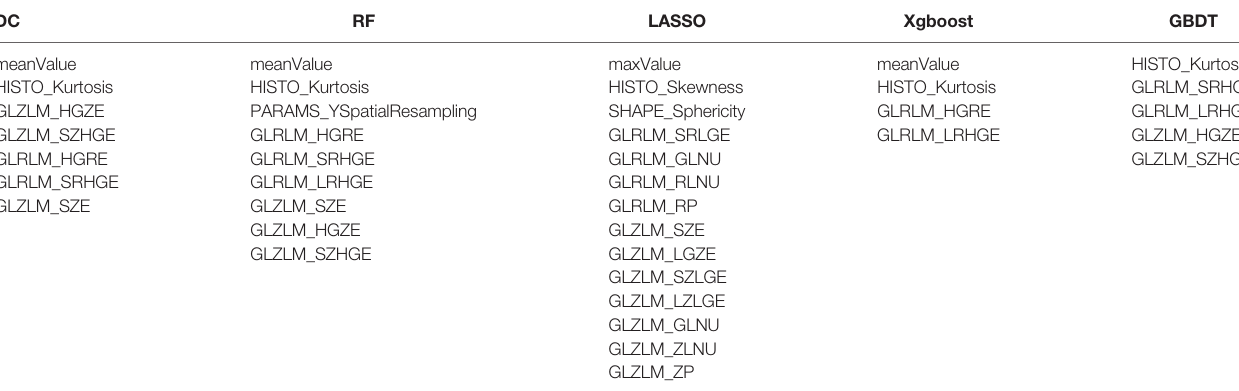
DC, distance correlation; RF, random forest; LASSO, least absolute shrinkage and selection operator; Xgboost, eXtreme gradient boosting; GBDT, gradient boosting decision tree; GLZLM, gray-level zone length matrix; HGZE, High Grey Level Zone Emphasis; GLRLM, Gray Level Run Length Matrix; SZHGE, Short Zone High Grey Level Emphasis; HGRE, High Gray Level Run Emphasis; SRHGE, Short-Run High Grey Level Emphasis; SZE, Short Zone Emphasis; LRHGE, Long-Run High Grey Level Emphasis; SRLGE, Short-Run Low Grey Level Emphasis; GLNU, Grey Level Non-Uniformity; RLNU, Run Length Non-Uniformity; RP, Run Percentage; LGZE, Low Gray Level Zone Emphasis; SZLGE, Short Zone Low Grey Level Emphasis; LZLGE, Long Zone Low Grey Level Emphasis; ZP, Zone